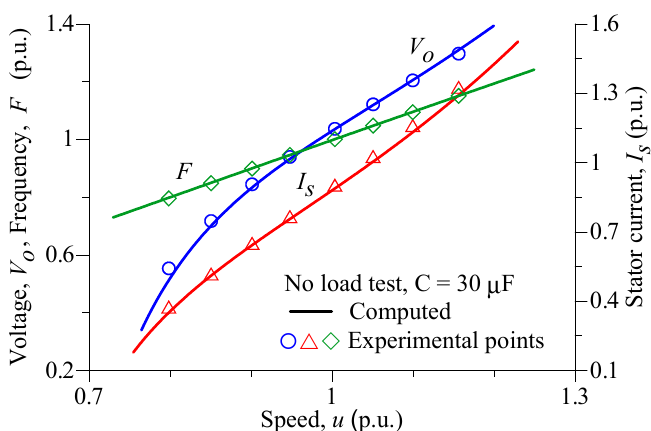
Figure 13. Terminal voltage V o and stator current I s versus excitation capacitance C under no load when speed ( u ) = 1 p.u.